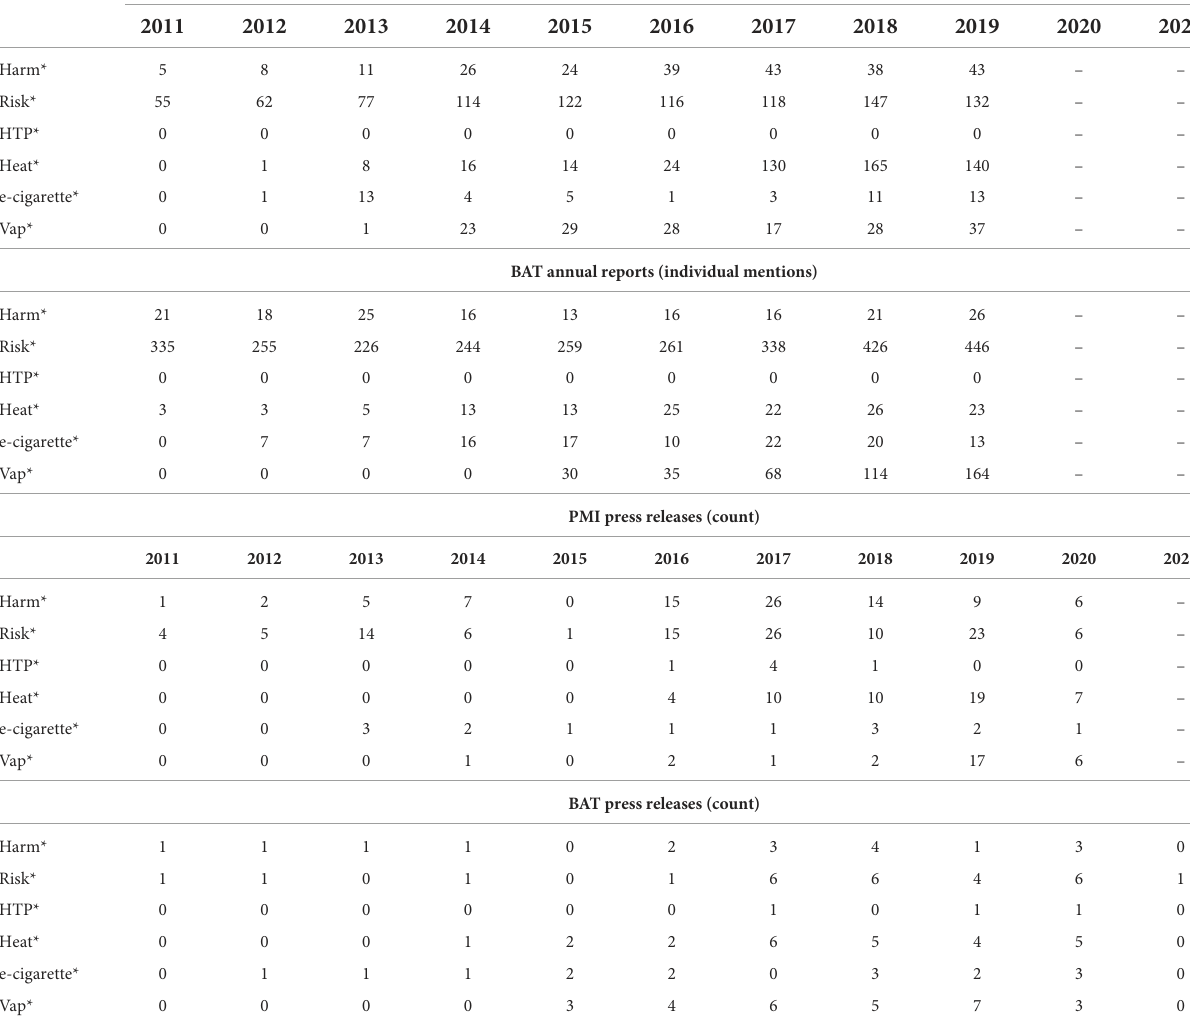
TABLE 2 Results returned for each keyword, split by year and sample